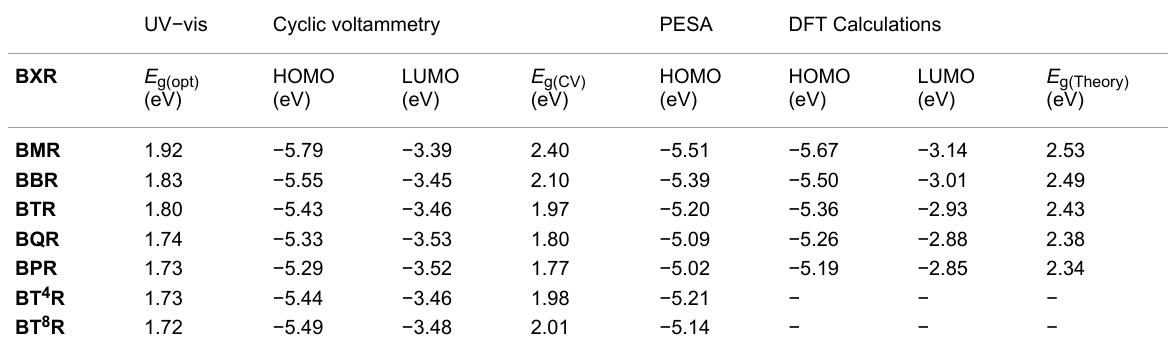
Table 3: Extracted UV–vis absorption peak position for BX x R . UV − vis Cyclic